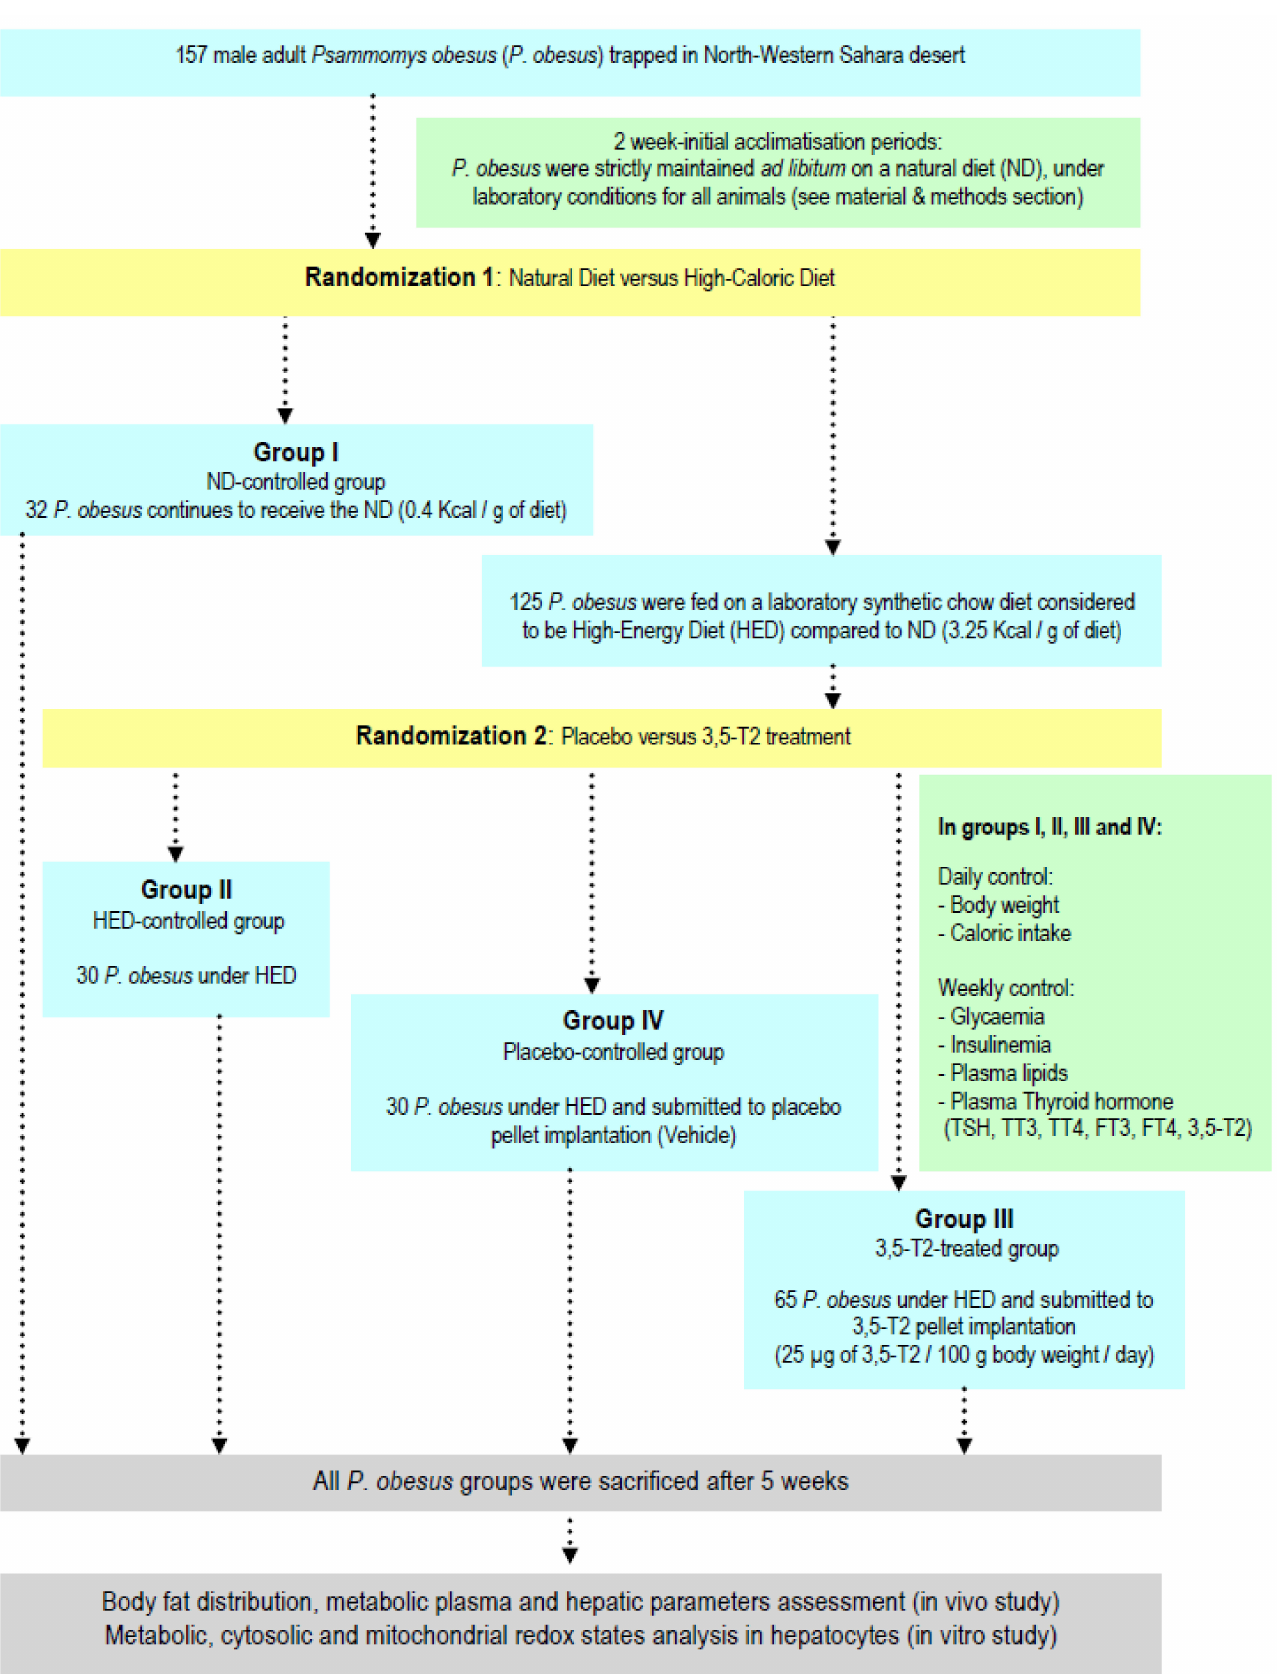
Figure 1. Experimental protocol design in desert gerbils Psammomys obesus